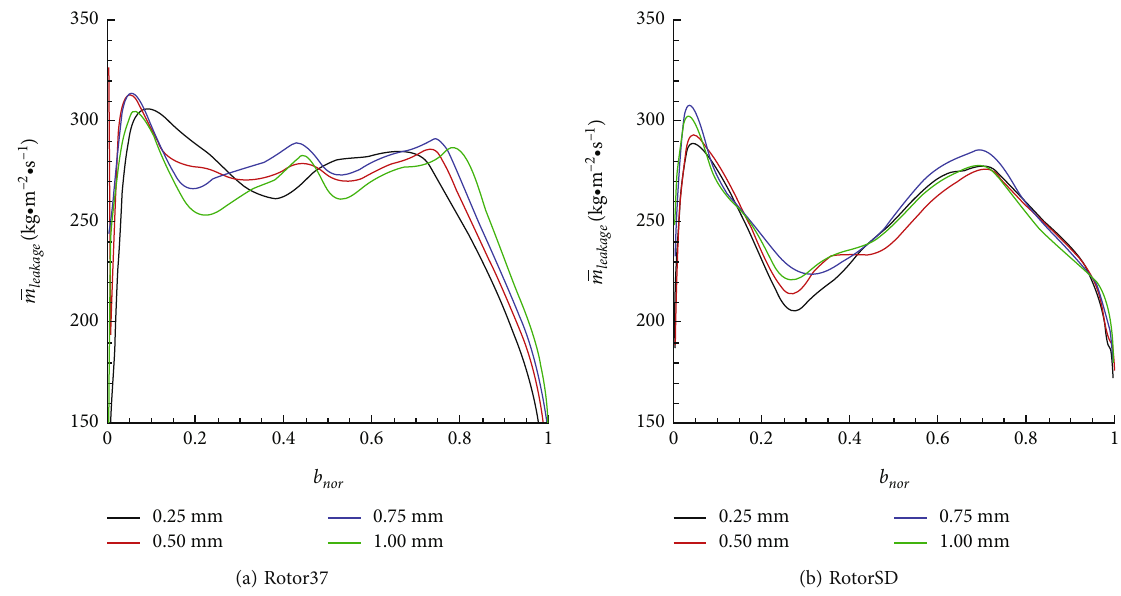
Figure 25: Distributions of the average leakage fl ow rate at the four tip